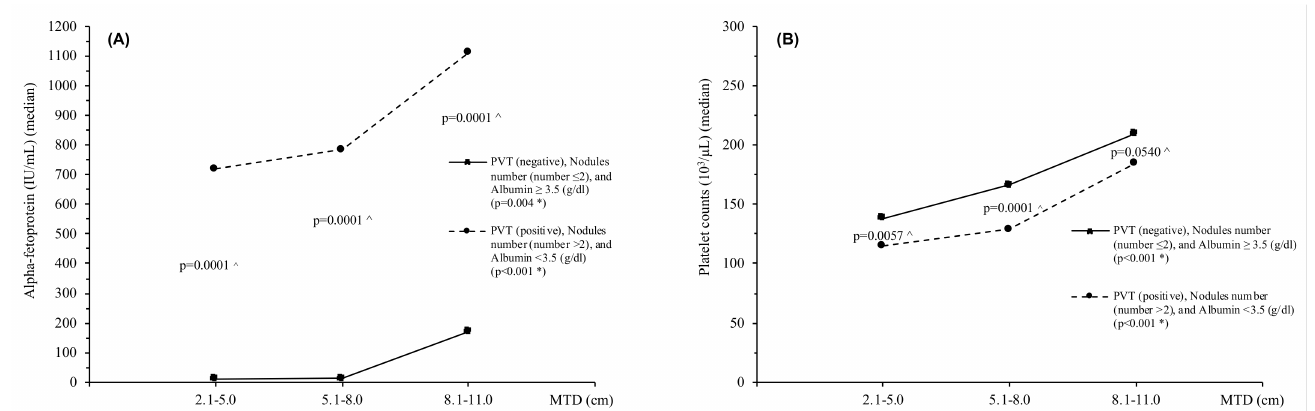
Figure 1. Trends of median values for serum AFP levels ( A ) and platelet counts ( B ) in relation to MTD categories for patients with PVT (negative), nodule number ( ≤ 2) and albumin ≥ 3.5 (g/dL) vs. patients with PVT (positive), nodule number (>2) and albumin <3.5 (g/dL), respectively. * Test for trend, ˆ Kruskal–Wallis rank test. Abbreviations: MTD, maximum tumor diameter; AFP, alpha-fetoprotein; Plt, Platelet